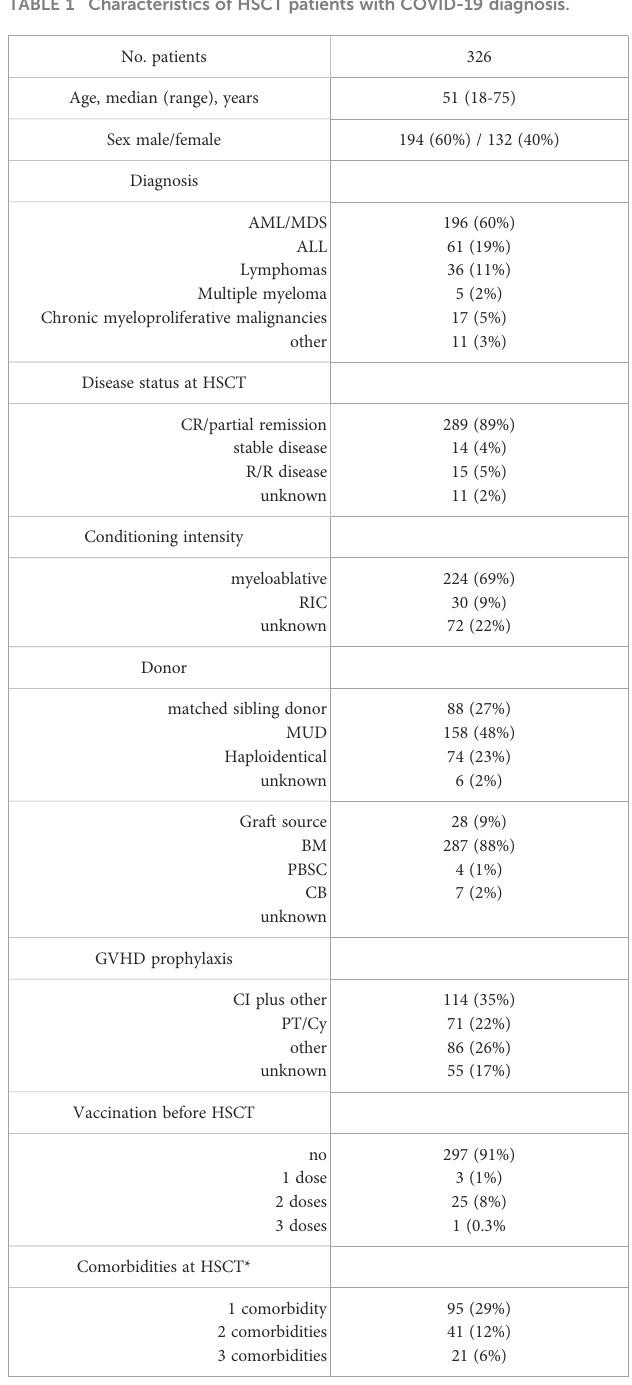
TABLE 1 Characteristics of HSCT patients with COVID-19